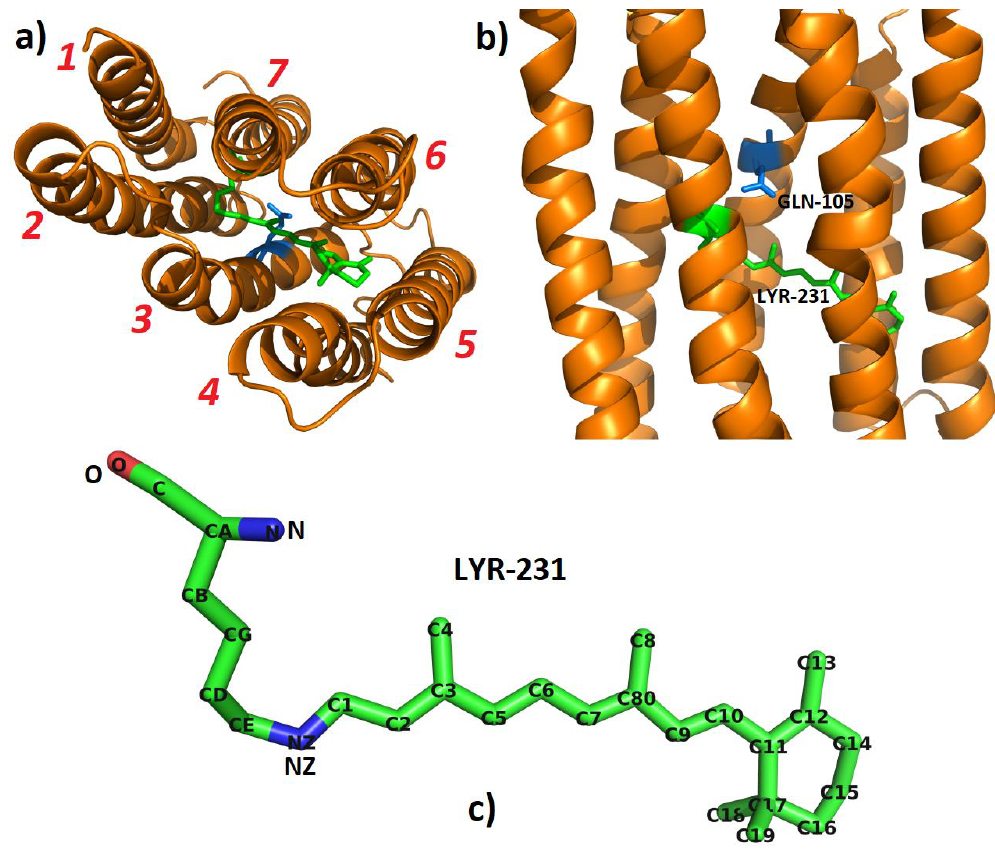
Figure 2. ( a ) The top view of PR. ( b ) The side view of PR. In ( a , b ), the green moiety denotes the chromophore, and the blue moiety is residue 105. ( c ) The structure of LYR and all hydrogens were removed for simplicity. All atom names are marked for clarity.